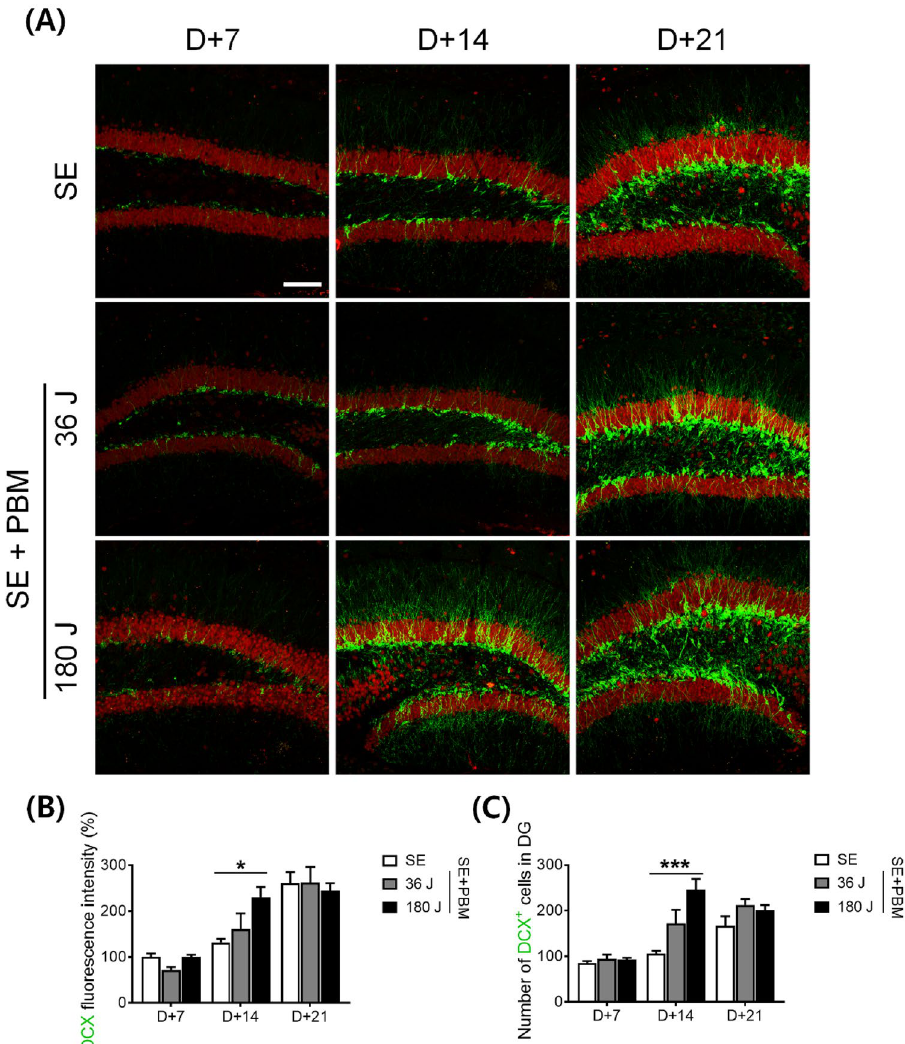
Figure 5. PBM increased undifferentiated/early neuronal cell population in the DG of the hippocampus after SE. ( A ) Representative coronal section views of Z-stacks obtained by confocal microscopy show the localization of DCX positive cells in the SGZ of the hippocampal DG. Immunostaining was performed with NeuN (for mature neuron, red) and DCX (for immature neuron, green). Scale bar 100 µm. ( B ) Quantification of the DCX fluorescent intensity in SGZ are shown. Expression of DCX fluorescent intensity are increased in 180 J PBM treated groups compared to the SE group only at 14 day. The quantitative data are presented as the mean ± SEM. *P < 0.05 compared with to SE group. ( C ) Quantification of the DCX positive cells in SGZ are shown. DCX positive cells are increased in 180 J PBM treated groups compared to the SE group only at 14 day. The quantitative data are presented as the mean ± SEM. ***P < 0.001 compared with to SE group. This figure was generated with Microsoft Visio version 2016 (Microsoft, Redmond, WA,